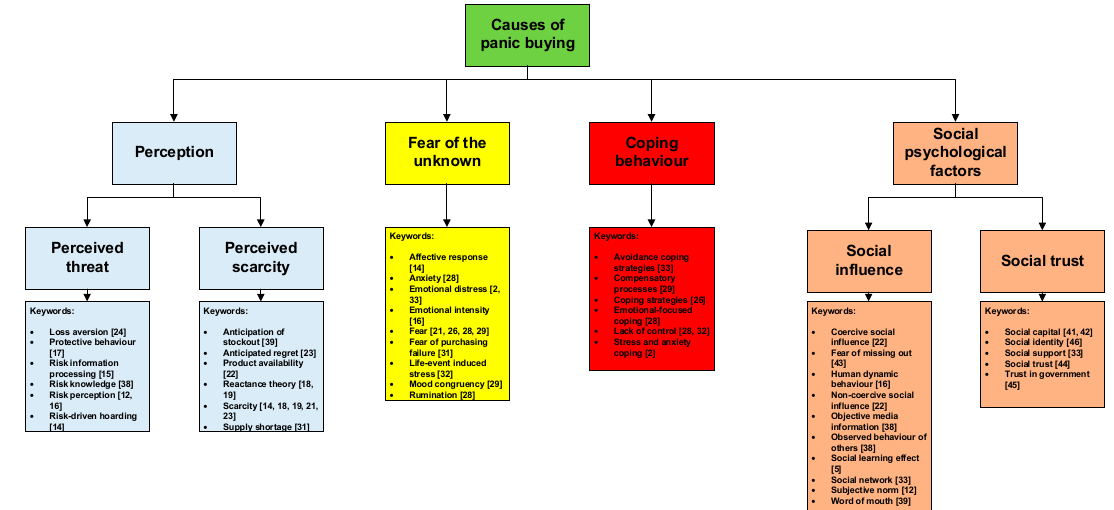
Figure 2. Themes, subthemes, and associated keywords.